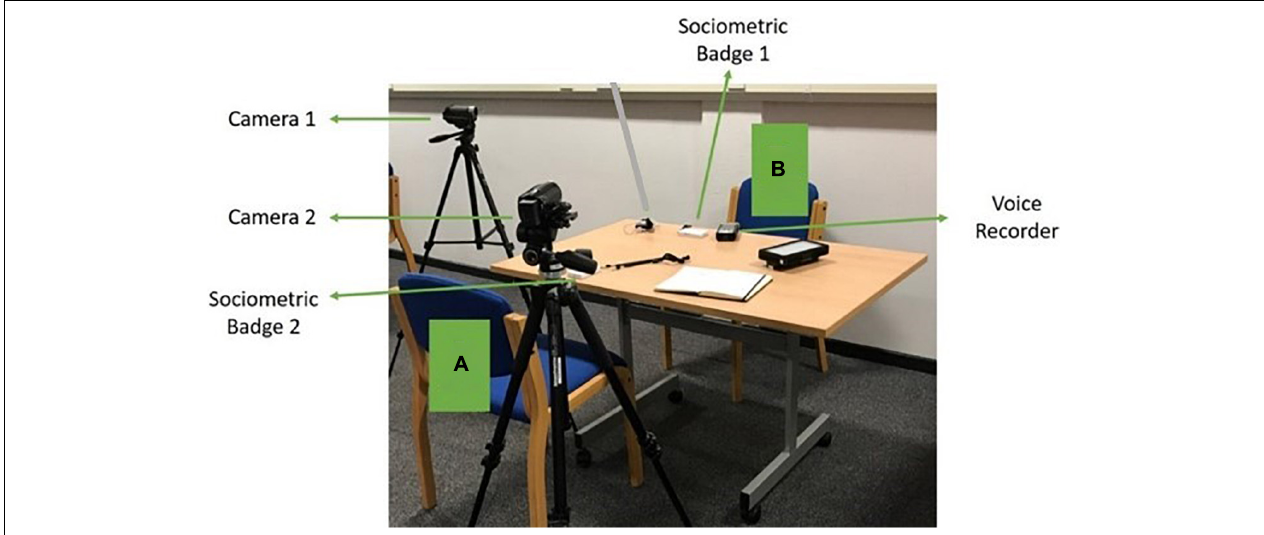
FIGURE 1 | Study layout of both radio and on-camera training sessions. Cameras were only turned on for recording during the on-camera interview. (A) Journalist position. Both cameras are facing the participant (B) for more accurate post hoc face recognition. The added voice recorder was for a better-quality recording of